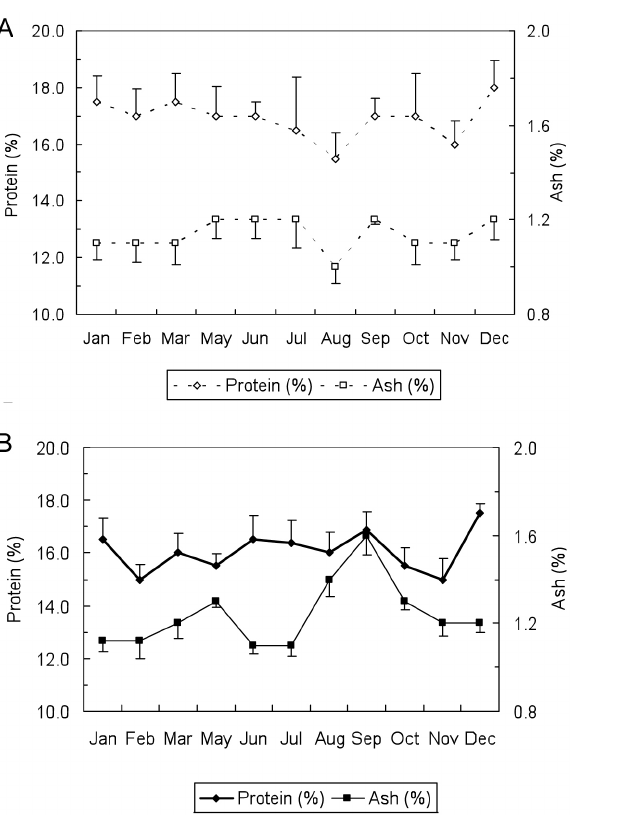
Fig . 2 – seasonal evolution of protein and ash content in black scab- bardfish fillets (a, skin-on; B, skinless).